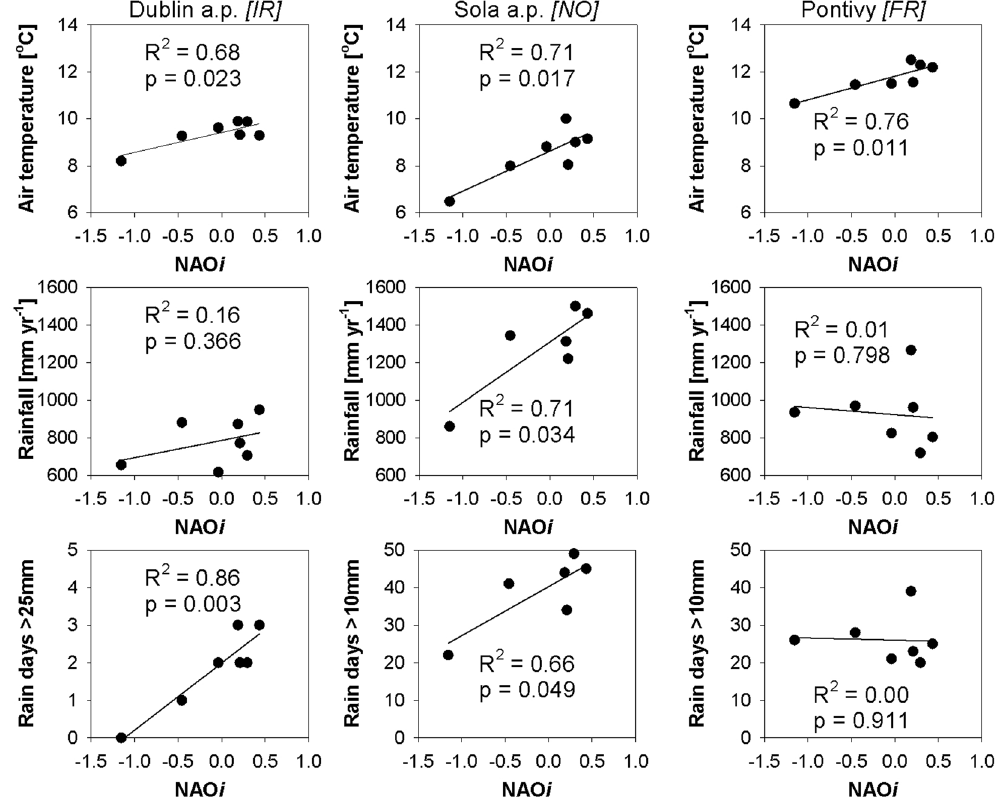
Figure 2. Examples of the impact of a sharp rise in NAOi to annual mean air temperature (top), annual total rainfall (middle) and annual number of rain days exceeding 10 mm or 25 mm (low) correlated to NAO i for three meteorological stations, Dublin airport (Met Éireann, Ireland), Sola airport (Norwegian Meteorological Institute, Norway) and Pontivy (Meteo France, France) for the period